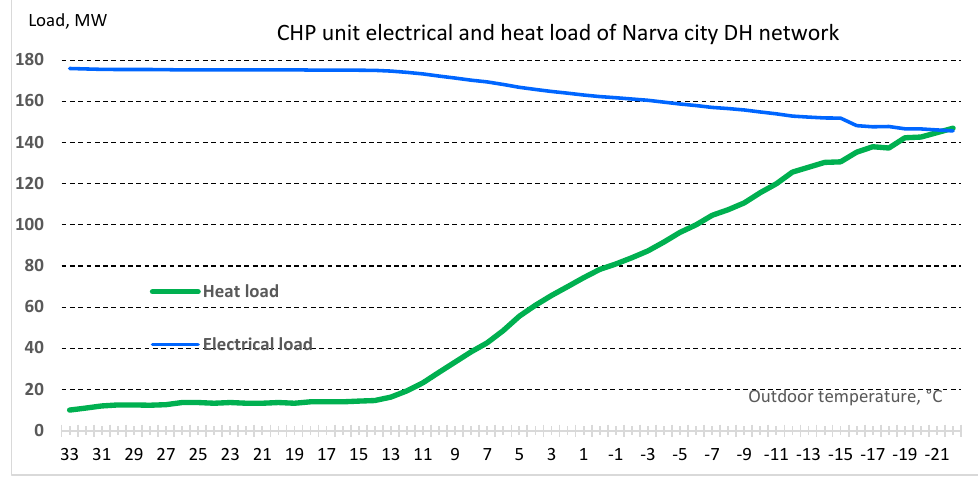
Figure 7. CHP unit electrical load and heat load according Narva city DH network.